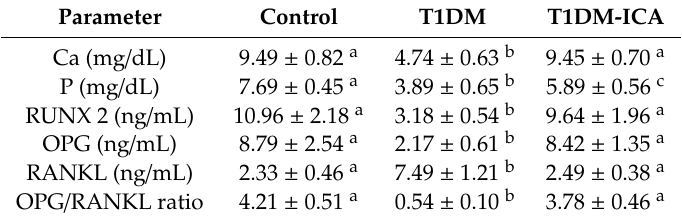
Table 2. Serum calcium (Ca), phosphorus (P), osteoprotegerin (OPG), receptor activator of nuclear factor- κ B ligand (RANKL), and runt-related transcription factor 2 (RUNX 2) in each experimental group.